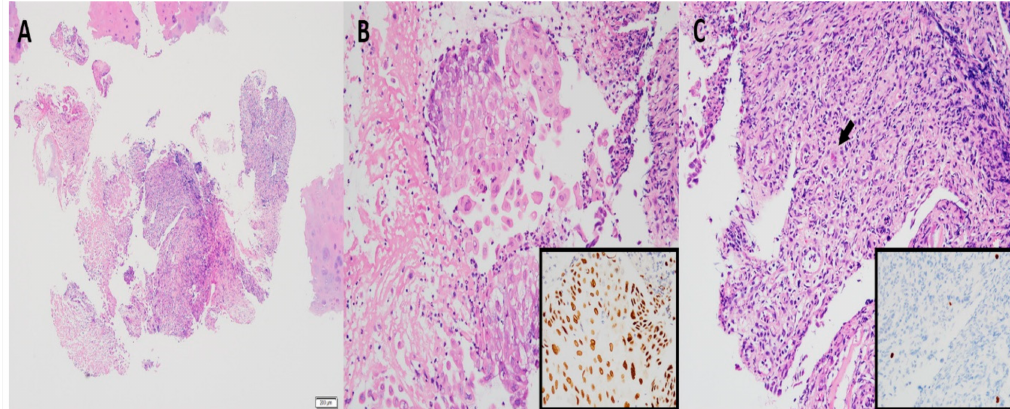
Figure 4. Representative images of hematoxylin and eosin and immunohistochemical staining (IHC). ( A ) An ulcer with granulation tissue and reactive squamous cell atypia is observed. ( B ) The keratinocytes present with the viral cytopathic changes of ground glass nuclei, nuclear molding, and multinucleated giant epithelial cells. IHC using the herpes simplex virus antibody was positive (inset). ( C ) An ulcer and granulation tissue with viral infected cells are noted (arrow), which were positive for cytomegalovirus (inset). The blue color indicates the hematoxylin counterstain. Original magnification,